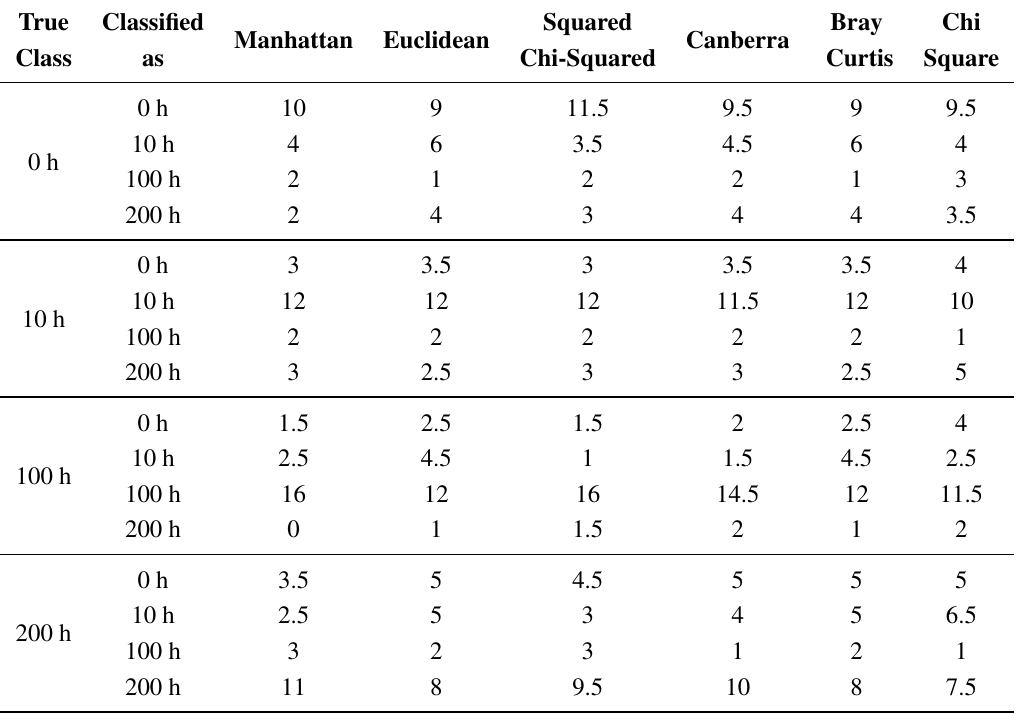
Table 3. Confusion matrix of the classification means for the 4-MHz frequency pulse echo signals at 650 ◦